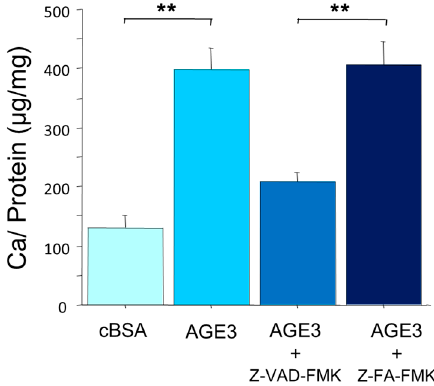
Figure 1. Glycolaldehyde-derived advanced glycation end-products-bovine serum albumin (AGE3-BSA) (100 µg/mL) increased calcium deposition in a rat vascular smooth muscle cell line and it was inhibited by caspase inhibitor. After reaching confluency, A7r5 cells were incubated with calcification medium containing control BSA (cBSA) or AGE3-BSA in the presence or absence of general caspase inhibitor Z-VAD-FMK (10 µM) or the control Z-FA-FMK (10 µM) for three days. Then, the calcium deposition was measured as described in the Method Section. To determine statistical significance, the results were analyzed by unpaired t -test, and the statistical significance was denoted as follows, ** p < 0.001.